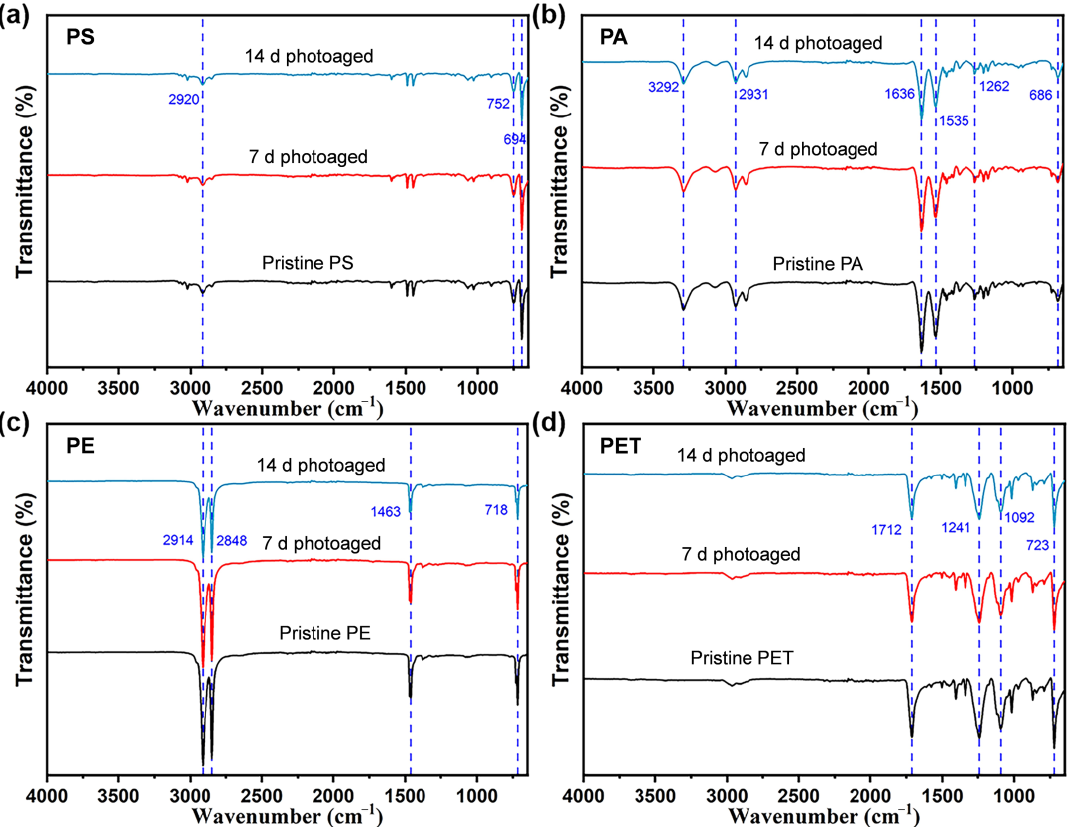
Figure 2. Fourier transform infrared spectra (4000–650 cm − 1 ) of ( a ) PS, ( b ) PA, ( c ) PE, and ( d ) PET MPs after photo-irradiation for 0, 7, and 14 d. The number of samples for the repeated experiments is n = 3.